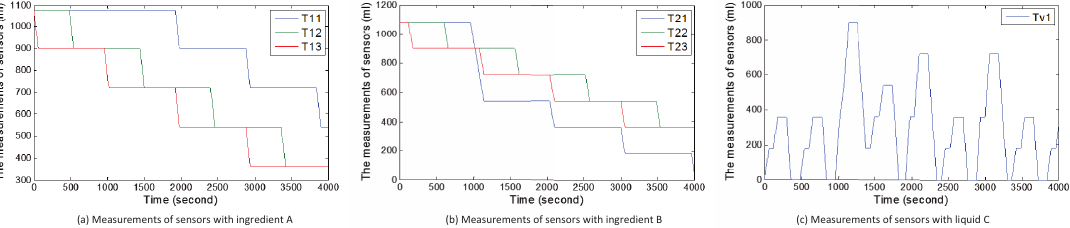
Figure 13. Measurements from sensors under attack case 2.